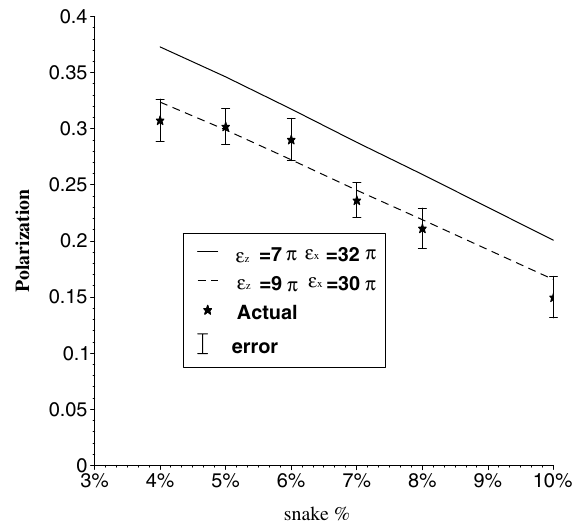
FIG. 6. Polarization after crossing the 0 (cid:5) (cid:28) and 0 (cid:5) (cid:28) u v resonances with fixed vertical and horizontal normal mode (cid:3) 8 : 8 , (cid:28) (cid:3) 8 : 7 ) versus partial snake strength. tunes ( (cid:28) v u Vertical and horizontal emittances were measured to be (cid:4) 8 (cid:18) 1 (cid:6) $ and (cid:4) 31 (cid:18) 1 (cid:6) $ mm mrad . In addition, a distributed roll of < 0 : 3 mrad was applied to the BD and CF magnets in the DEPOL calculated